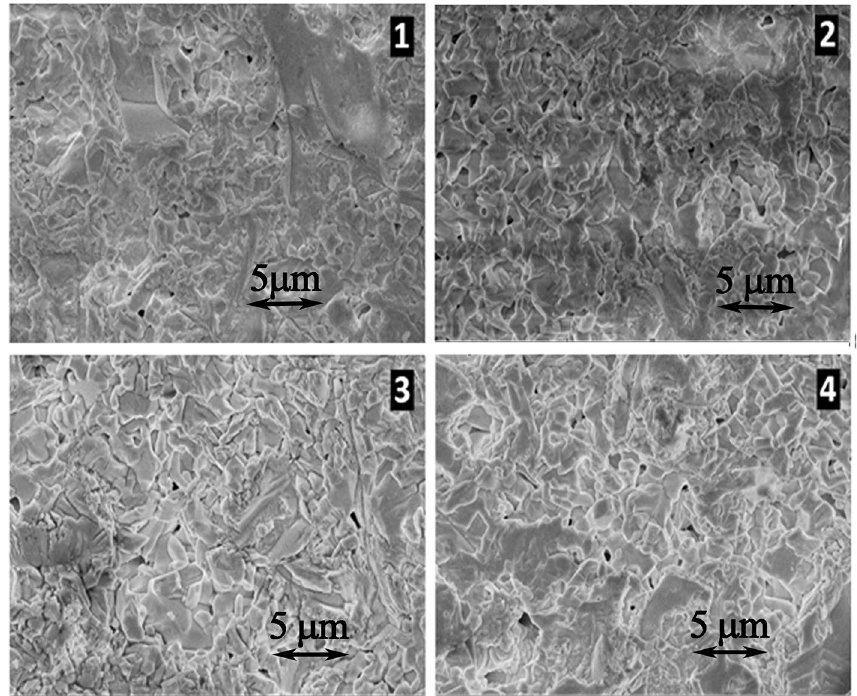
Figure 4. SEM images of the surfaces of ceramic samples (backscattered electron detector imaging) synthesized from Bi